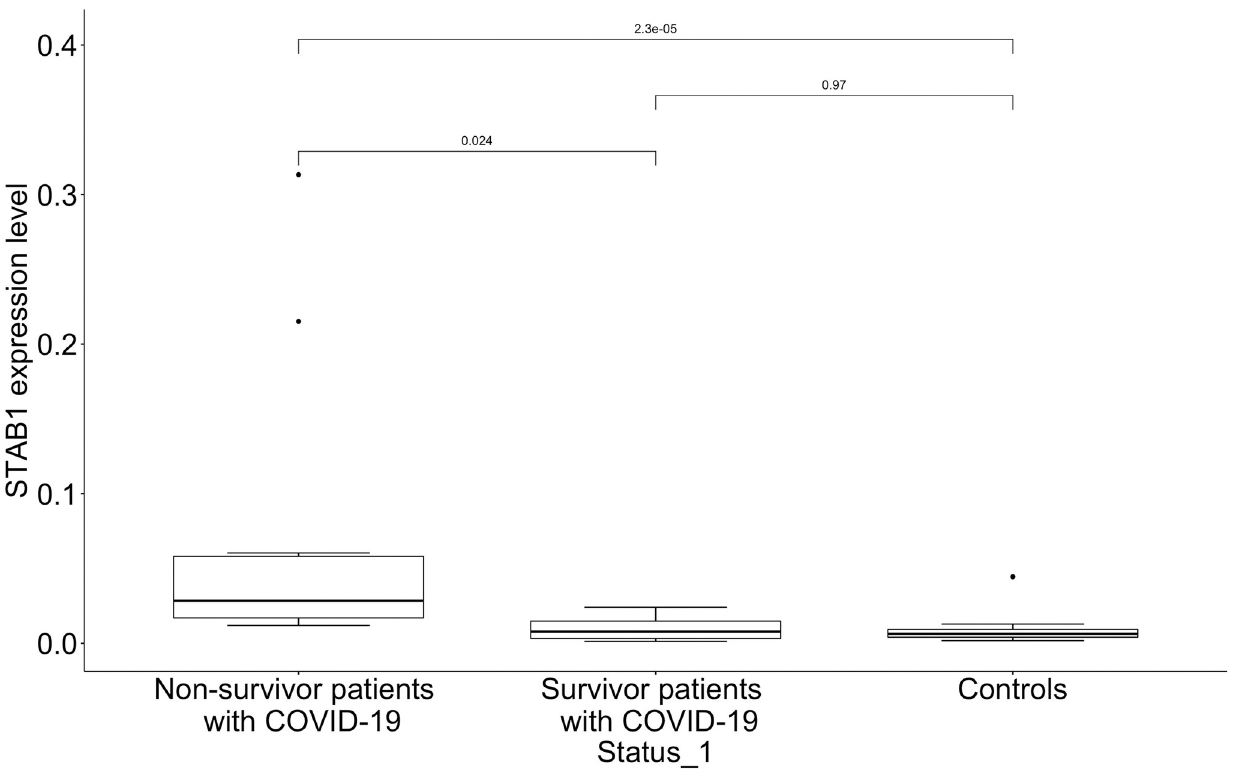
Fig 3. STAB1 expression level in PBMCs of COVID-19 patients infected by the Delta variant with different outcomes and controls.